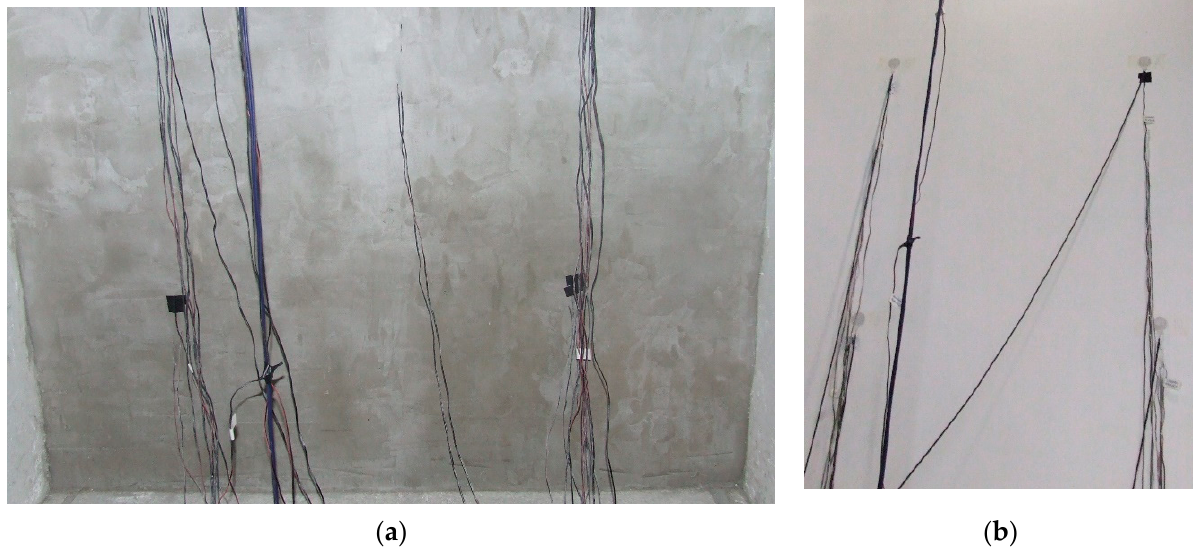
Figure 4. View of the finished inner surface of the wall with the measuring sensors installed: ( a ) before painting; ( b ) after painting and installation of surface sensors.